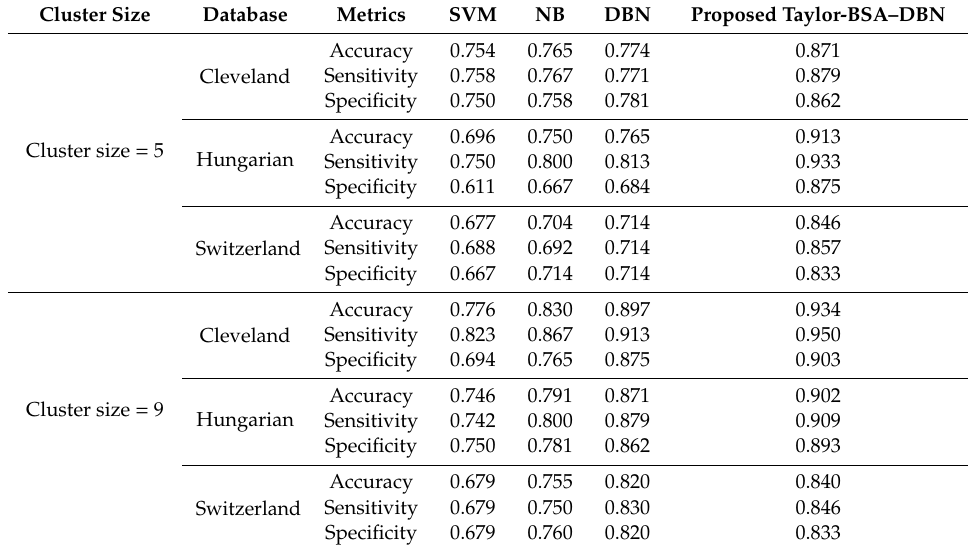
Table 10. Comparative analysis.